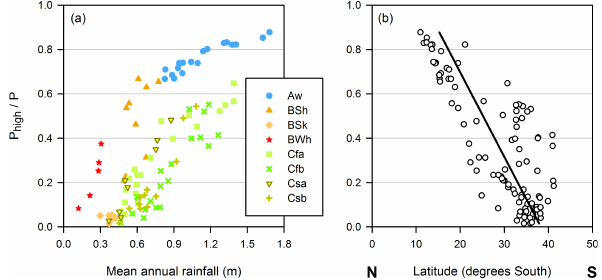
Fig. 13. (a) The proportion of high intensity rainfall ( P high ) in mean annual rainfall ( P ) for all modelled locations and (b) reduction in this ratio with increasing latitude (north to south of the